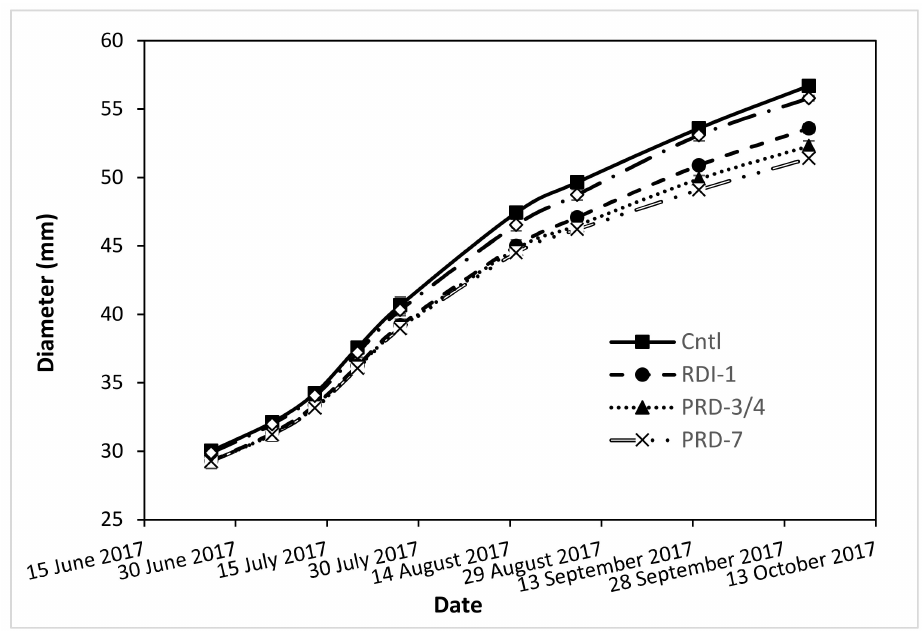
Figure 6. E ff ect of irrigation strategy on pattern of growth of fruit equatorial diameter for ‘Orogrande’ clementine. Table3. Linearregressionanalysisbetweenamountsofwaterapplied(x; in1000m 3